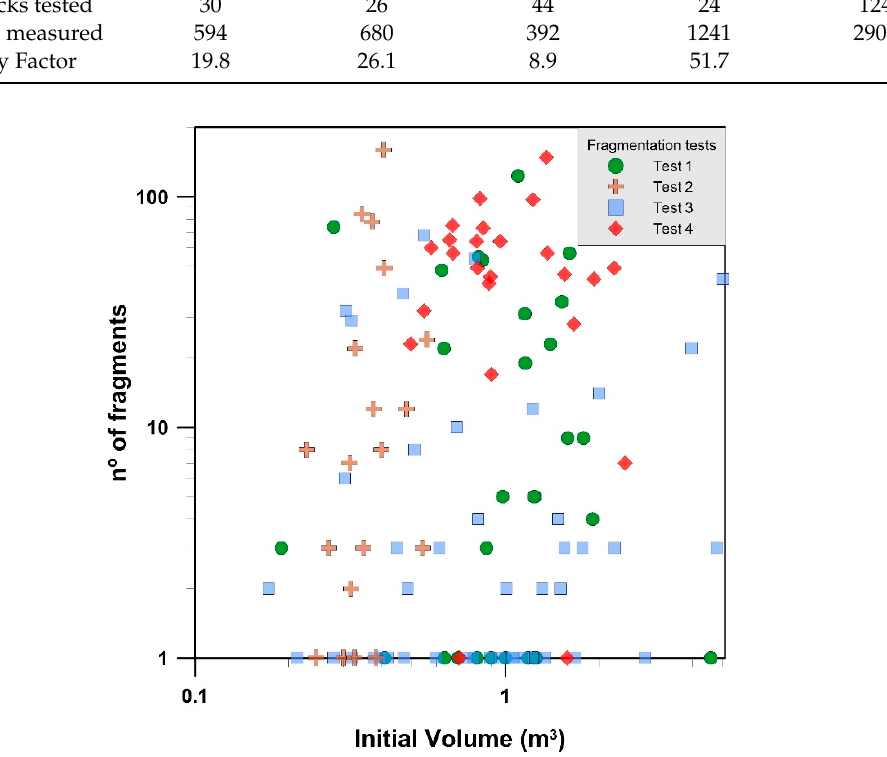
Figure 10. Number of fragments measured versus the initial volume of each block dropped.